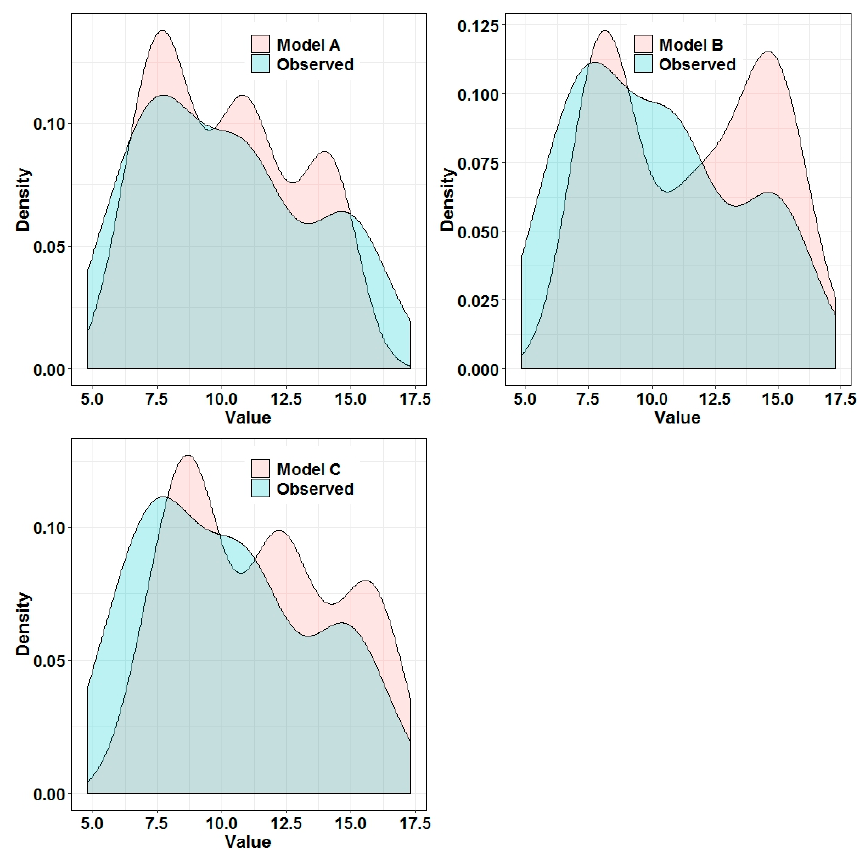
Figure 2. Density plots of soil organic carbon stocks (kg m − 2 ) derived from three boosted regression trees (BRT) models.